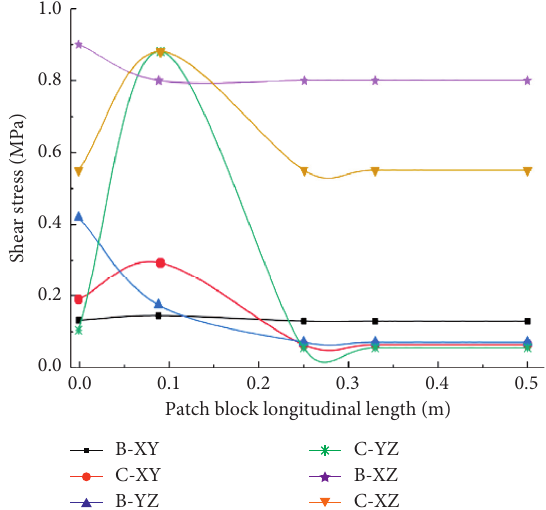
Figure 9: The effects of longitudinal movement of different loading positions on shear stress of joint filling material.